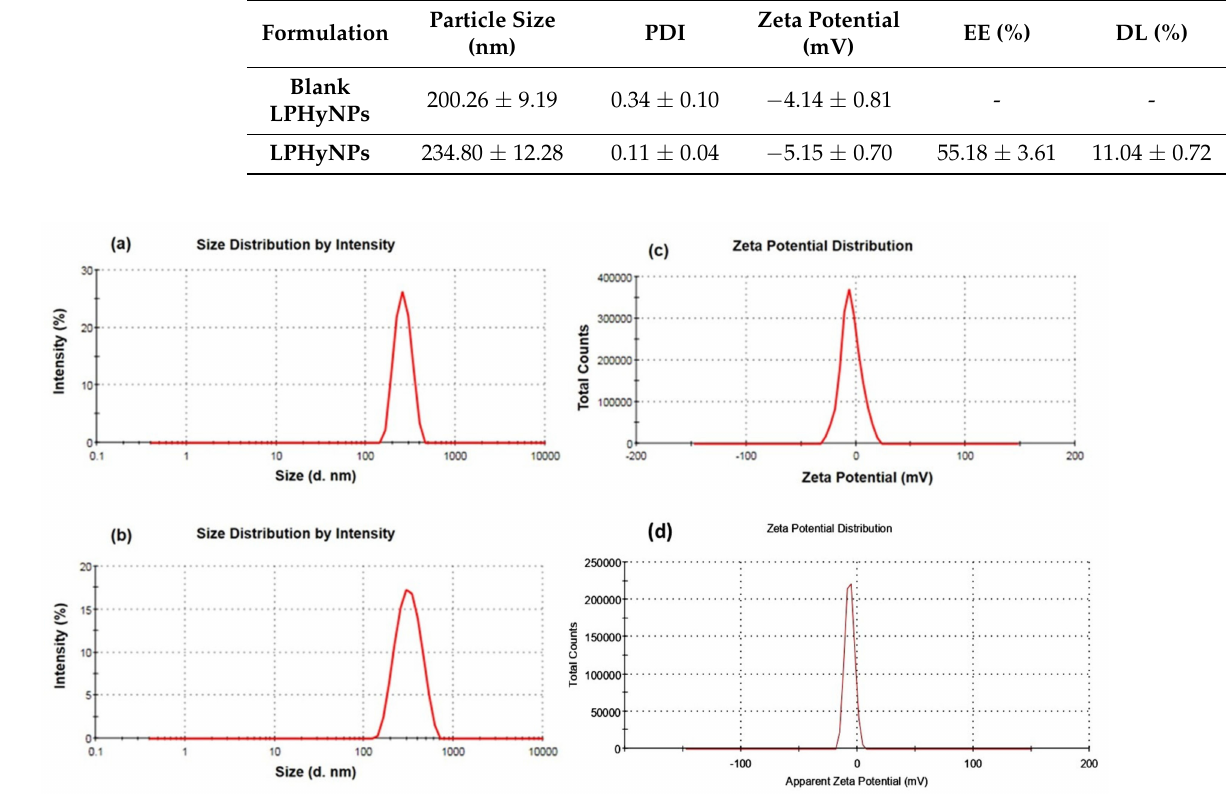
Table 2. Result of characterization of blank LPHyNPs and drug-contained LPHyNPs.